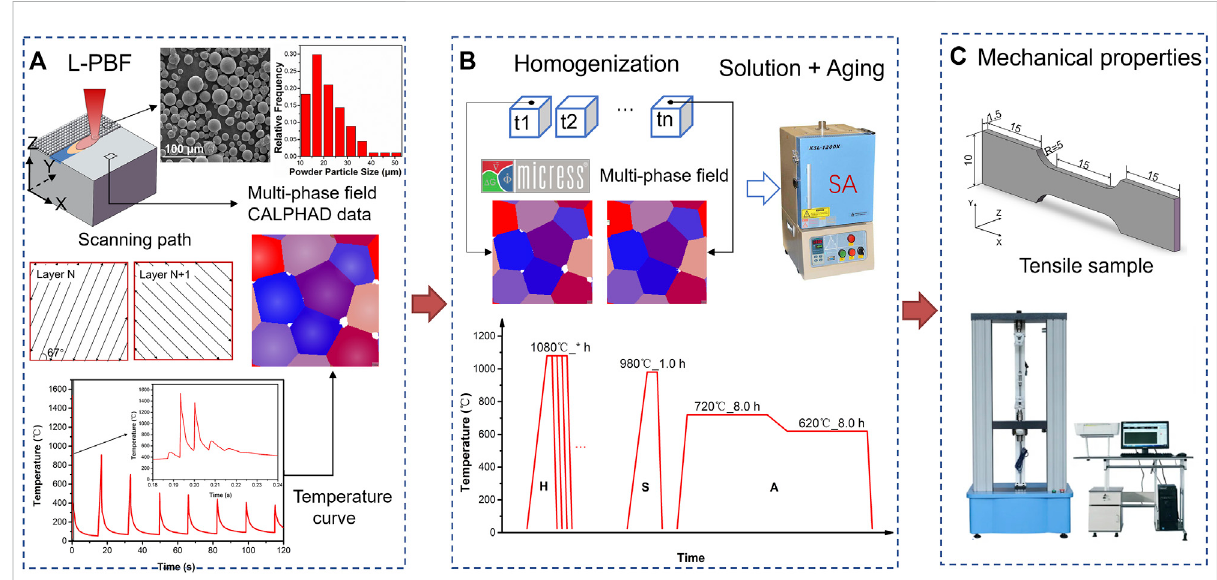
FIGURE 1 The research strategy of the L-PBF and subsequent homogenization heat treatment of Inconel 718 alloy, (A) phase- fi eld modeling of the microstructure of as-built samples, (B) phase- fi eld modeling under different homogenization time, and parameters of subsequent solution and double aging process, (C) mechanical